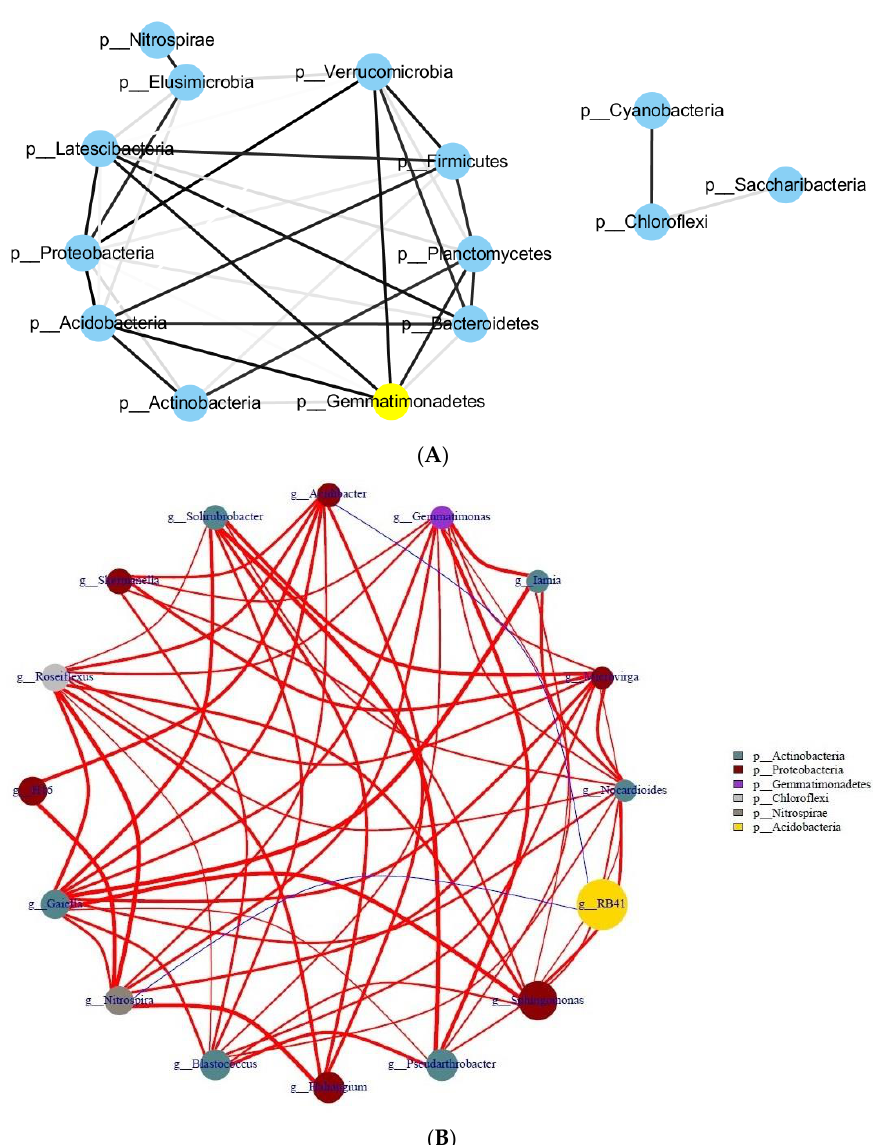
Figure 6. Network analysis of the 15 major bacterial phyla ( A ) and the 20 major bacterial genera ( B ) in soil treated with silicon fertilizer and microbial